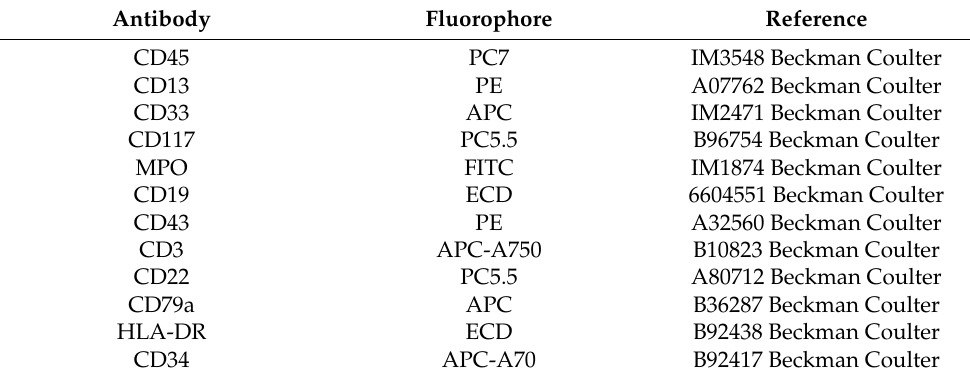
Table 2. Antibody fluorophores and